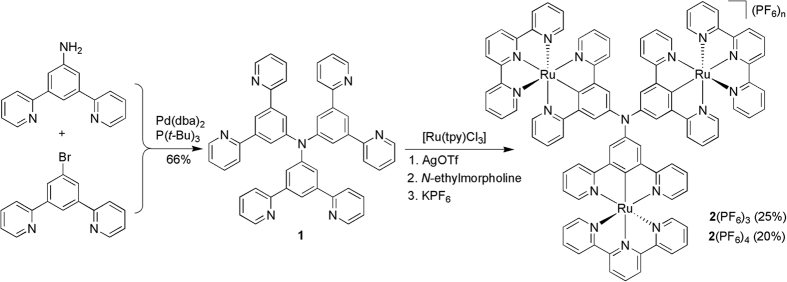
Synthesis of 2(PF6)3 and 2(PF6)4.